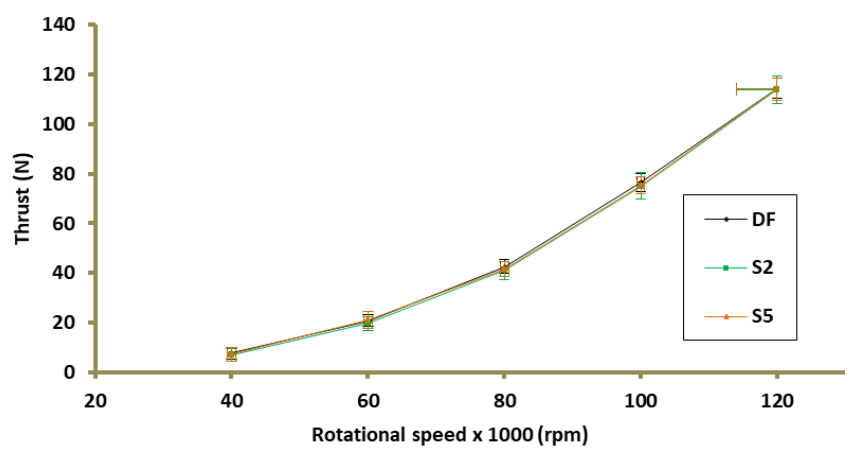
Figure 4. Turbine thrust as a function of rotational speed.